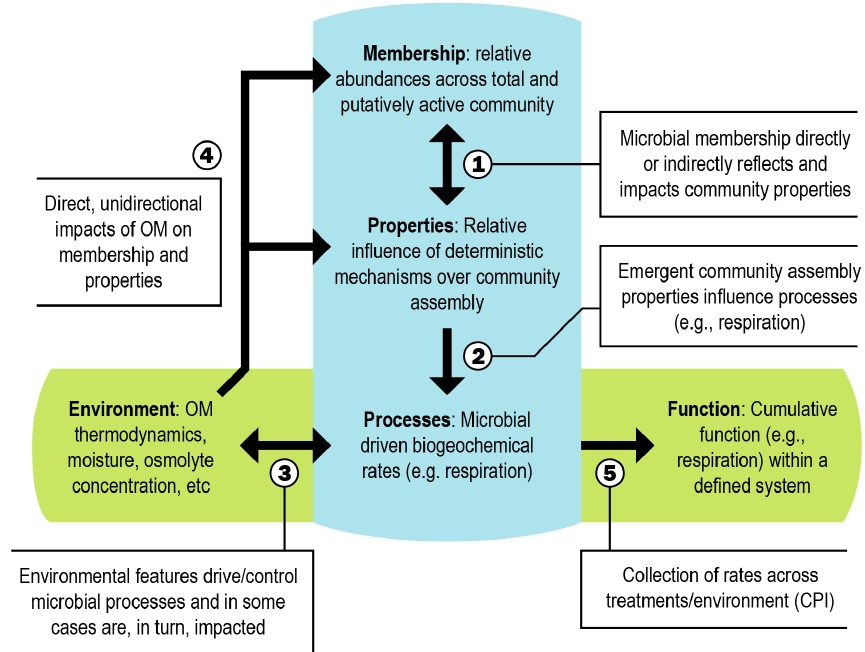
Figure 1. Integrated conceptual framework. The conceptual figure (modified from Hall et al., 2018) details relationships (indicated by numbered arrows) between cumulative properties of the microbial community (e.g., microbial membership, community assembly properties, biogeochemical rates), environmental features (e.g., organic matter (OM) thermodynamics), and emergent ecosystem function (e.g., control point influence (CPI)). Double-headed arrows indicate